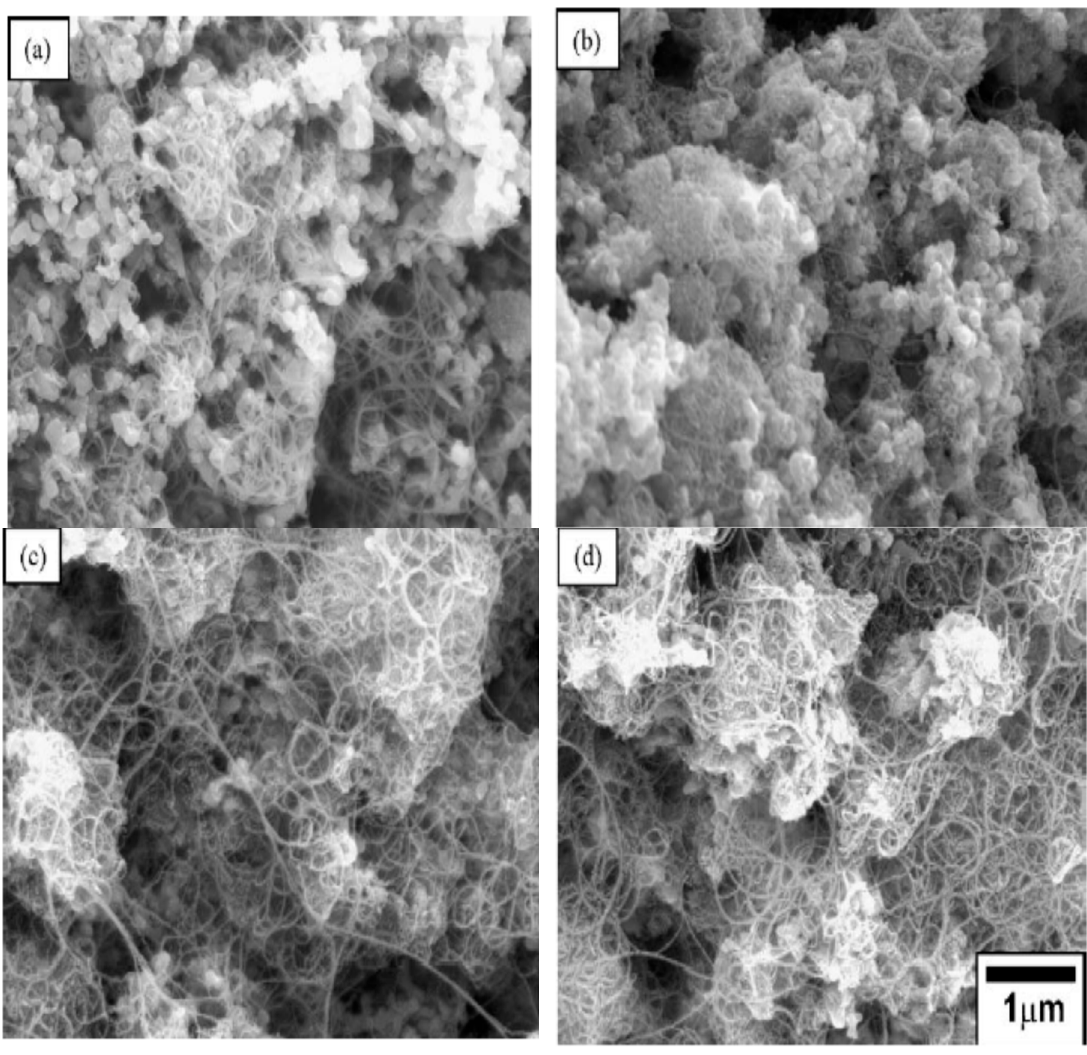
Figure 7. FE–SEM of Al 2 O 3 -CNT nanocomposites with varying CNT content ( a ) 7.39 wt%, ( b ) 8.25 wt%, ( c ) 18.82 wt% and ( d ) 19.10 wt%. Reproduced with permission from [156]. Copyright Elsevier, 2008.